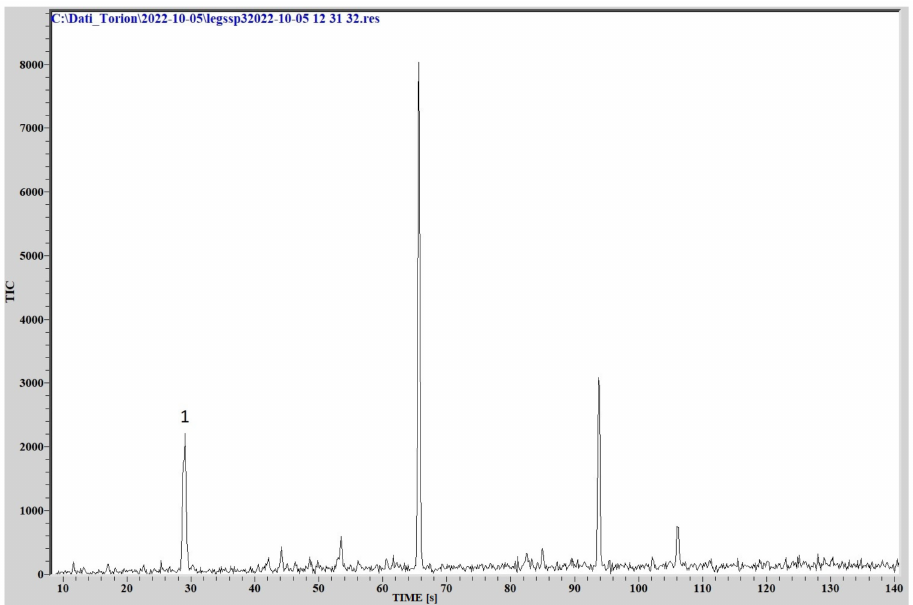
Figure 10. Chromatogram from L. species. (1) 1butanol- 3methyl. The analysis of the headspace of the culture of P. aeruginosa presents a completely dif- ferent chromatographic profile, producing a series of volatile substances, the most abundant of which was identified as 2-nonanone (C9H18O, molecular weight 142.2386, CAS Registry Number 821-55-6). Other substances identified are 2-undecanol (C11H24O, molecular weight 172.3077, CAS Registry Number 1653-30-1), 2-undecanone (C11H22O, molecular weight 170.2918, CAS Registry Number 112-12-9) and dimethyl sulfone (C2H6O2S, molecu- lar weight 94.133, CAS Registry Number 67-71-0). The relative chromatogram is reported in Figure 11.